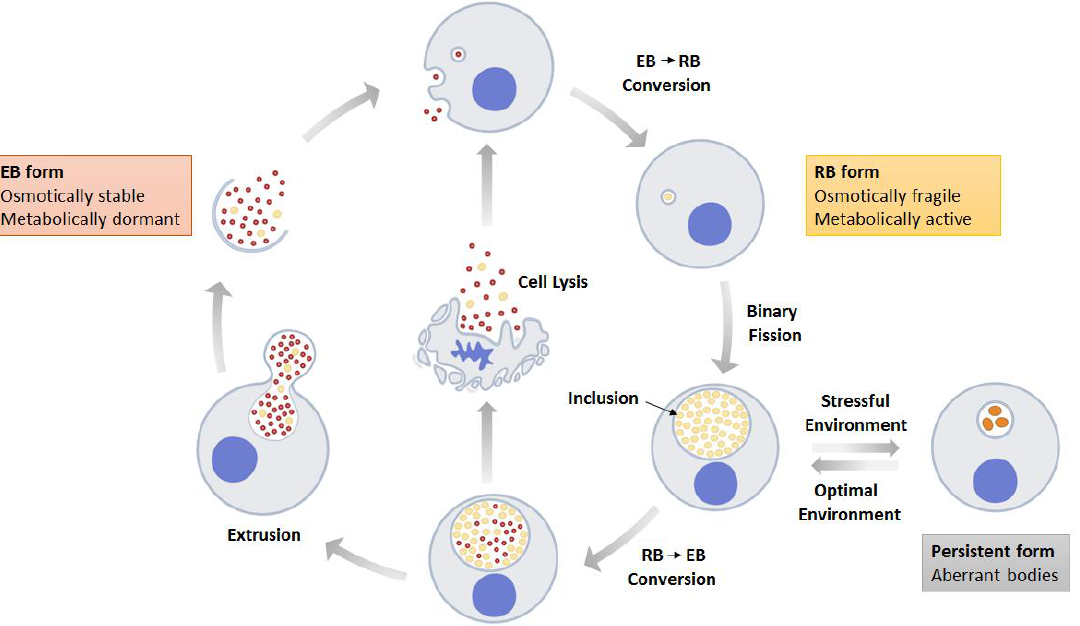
Figure 1. Schematic diagram of the developmental cycle of Chlamydia . Elementary bodies (EB; red dots) undergo conversion to reticulate bodies (RB; yellow dots) following attachment and internalization into the host cell. RB multiplies by binary fission and matures into EB before being released by lysis or extrusion processes. In the presence of growth stress such as IFN- γ , the RB enlarges and enters persistence. Optimal condition causes the enlarged RB to return to normal growth.